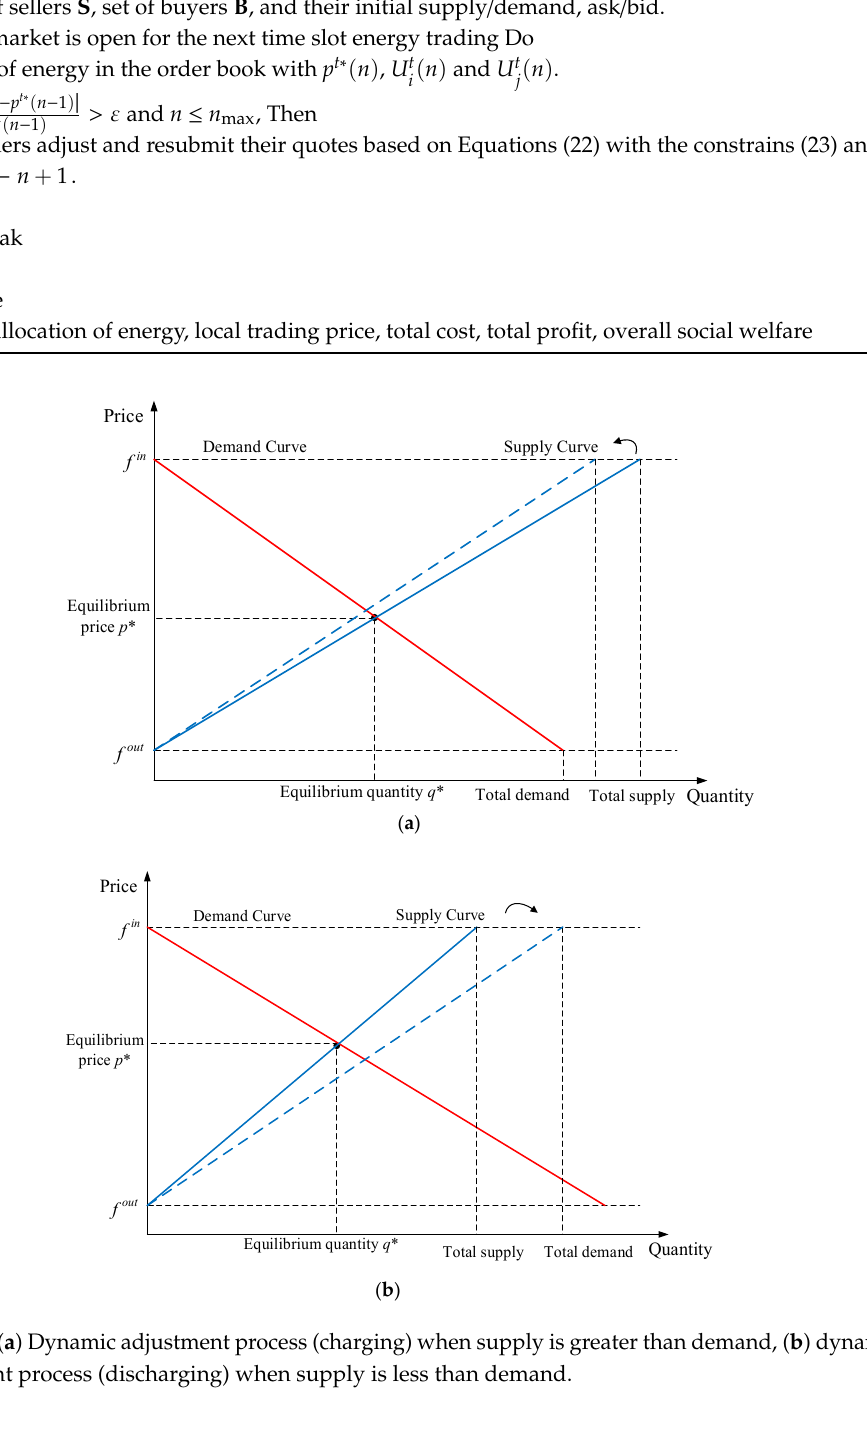
Algorithm 1. Iterative Auction Algorithm